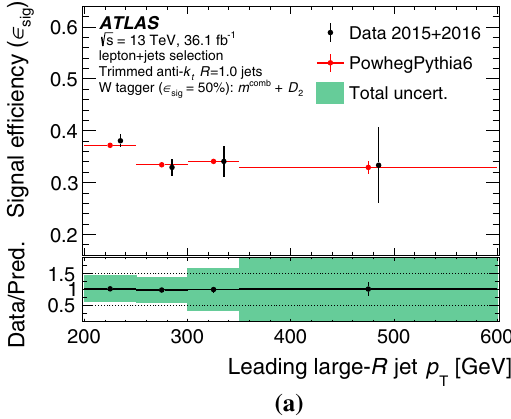
Fig. 17 The signal efficiency on contained W -boson jets for the two- variable m comb + D 2 W -boson tagger as a function of the large- R jet p T ( a ) and the average number of interactions per bunch crossing μ ( b ) in data and simulation. Statistical uncertainties of the signal efficiency measurement in data and simulation are shown as error bars in the top panel. In the bottom panel, the ratio of the measured signal efficiency in